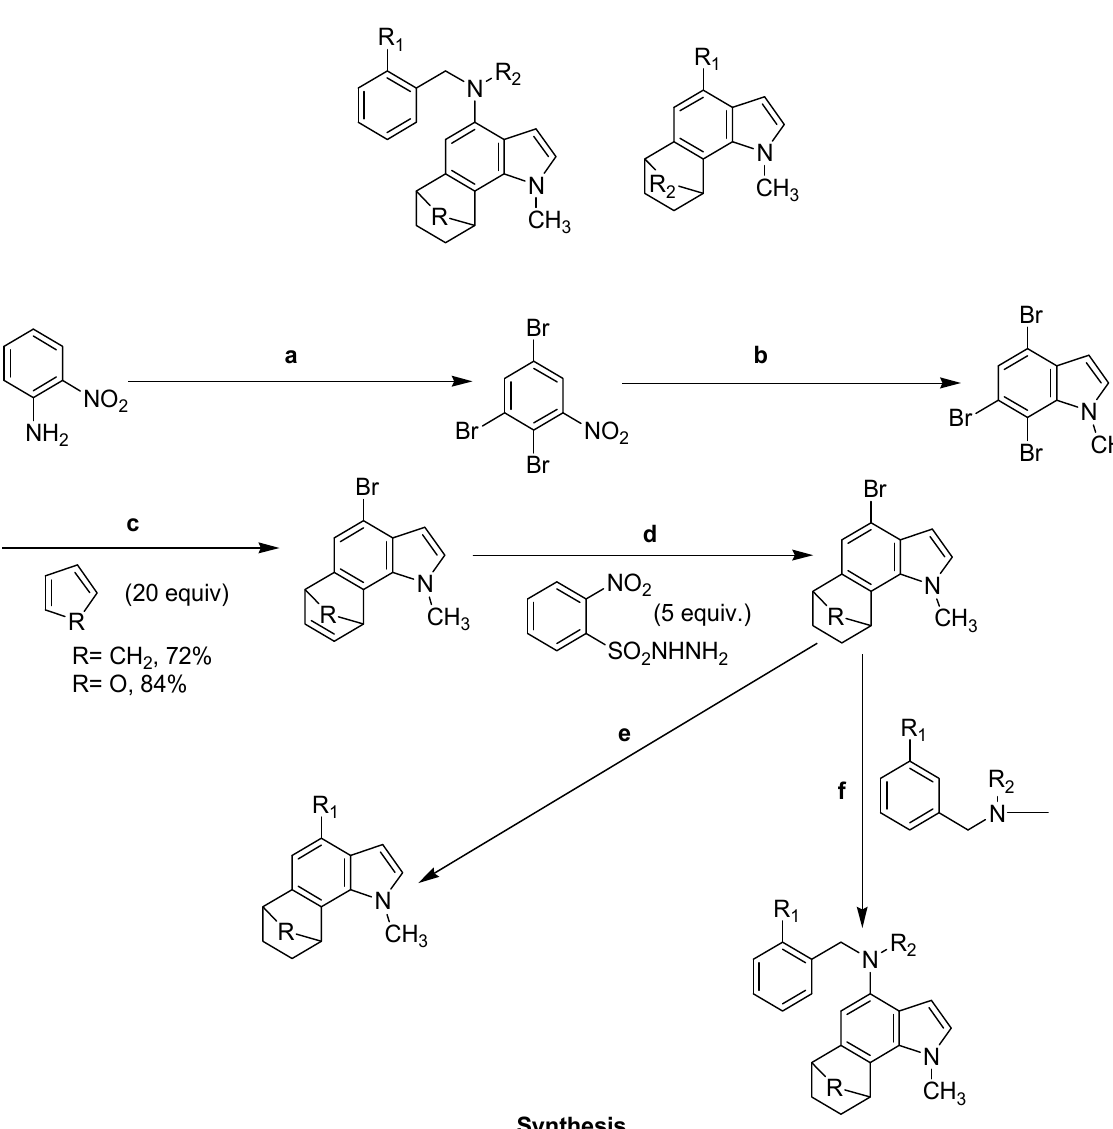
Figure 21. 6,7-Annulated-4-substituted